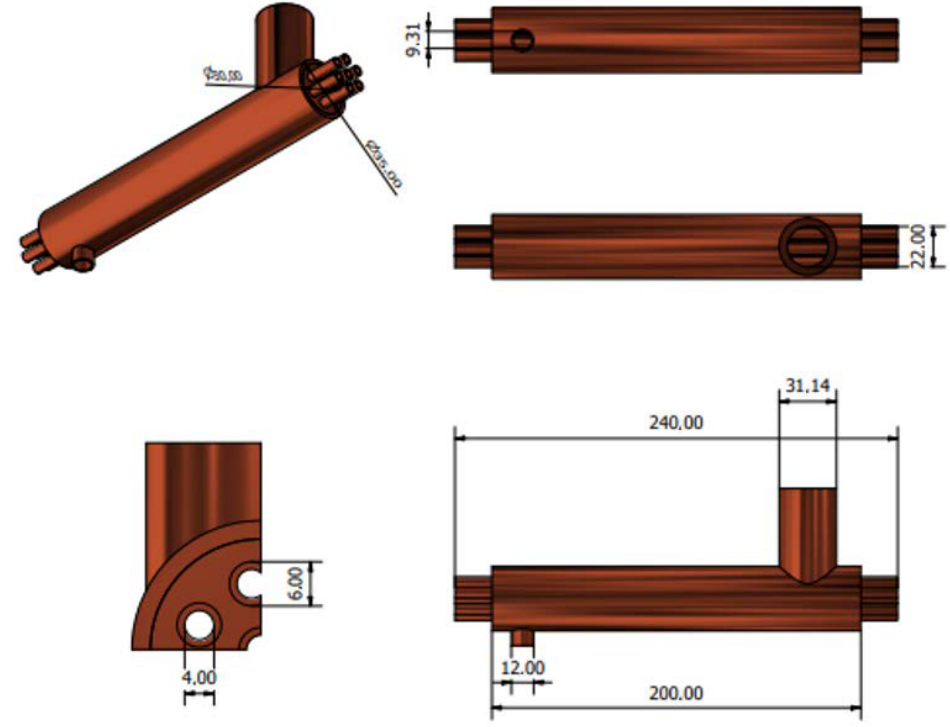
Figure 1. General view of the shell and tube heat exchanger.